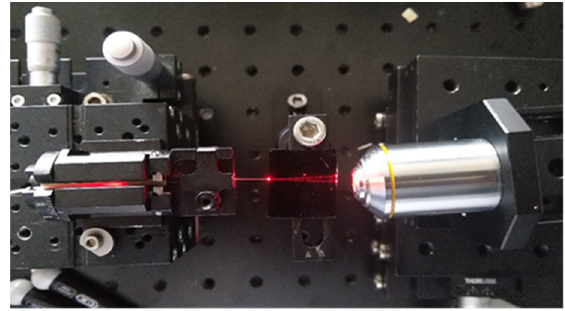
Figure 7. Top view of the light propagation within the waveguide.